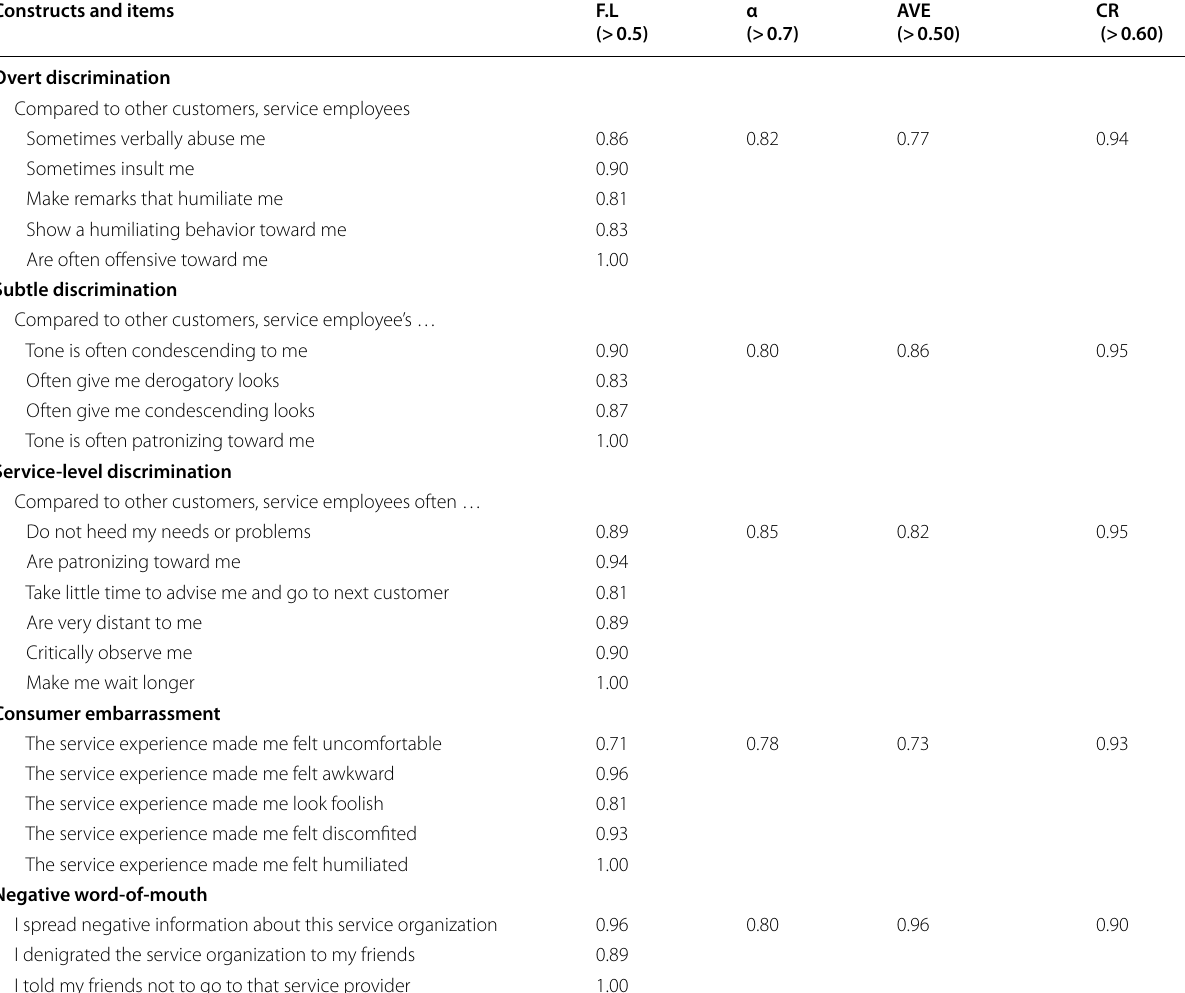
Table 3 Factor loadings, Cronbach alpha, AVE, and